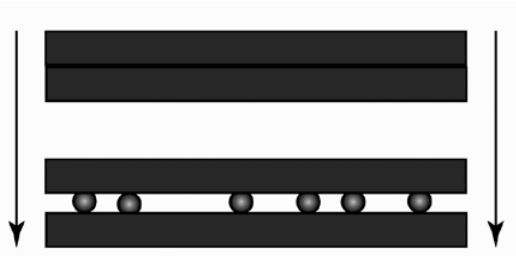
Illustration of the change in contact area as a result of the ad- dition of fumed silica. The particle surface cannot be changed to reduce contact area; however, fumed silica can be added to simulate the effect.